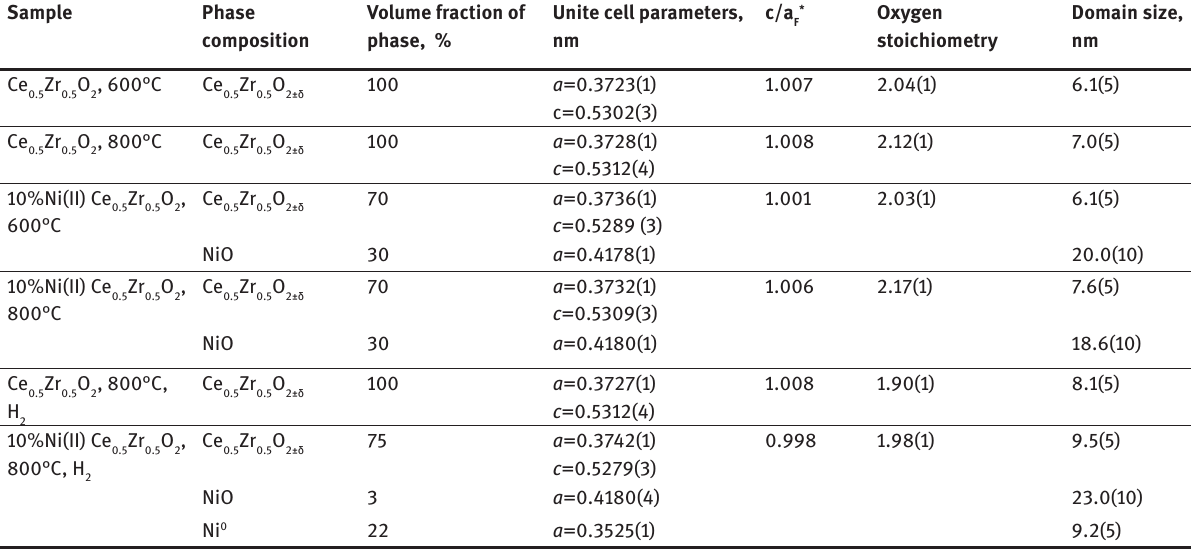
Table 1: Refinement of the structural parameters of Ce Sample